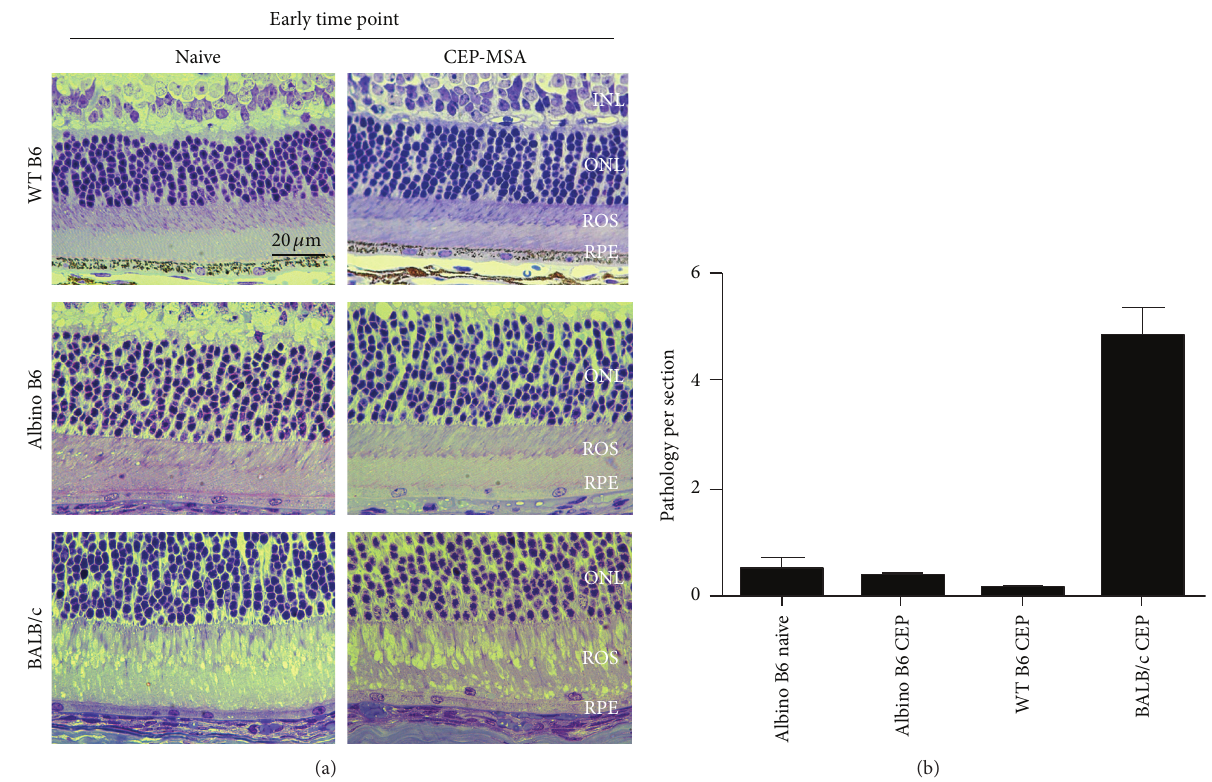
Figure 3: Immune-mediated cellular infiltration and development of outer retinal lesions are specific to genetic background and pigment independent. (a) Histology of CEP-MSA albino B6 mice compared to WT BALB/c and WT B6 at the early time point. Representative images are shown (from 3–5 mice per group per experiment; two or three independent experiments were performed for each strain). INL: inner nuclear layer; ONL: outer nuclear layer; ROS: rod outer segment; RPE: retinal pigment epithelium. Images were obtained using a 63x oil objective, and the scale marker represents a 20 𝜇 m length. (b) Quantification shows the lack of pathology at early time points in albino B6 mice, similar to WT B6 and in contrast to WT BALB/c mice. Mean values are shown; error bars represent